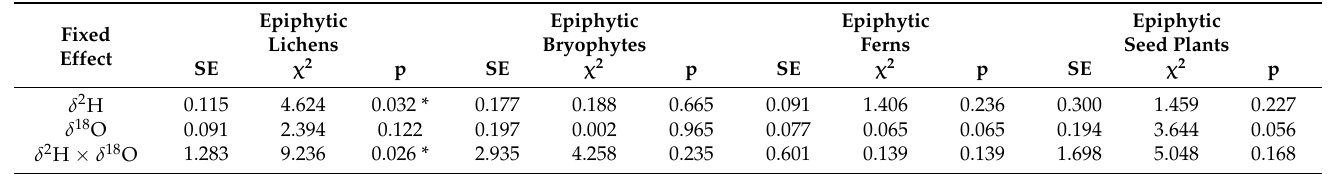
Table 1. Linear mixed model analysis of the effects of δ 2 H, δ 18 O, and their interactions on WUE i . ( δ 13 C) of epiphytes from different groups (* p < 0.05). The species of each group was incorporated as a random effect, but were not shown here for